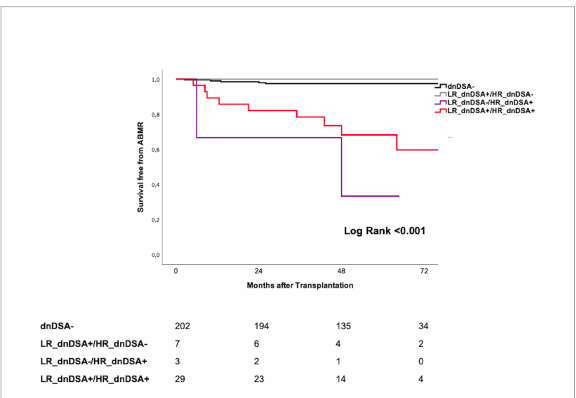
FIGURE 4 Kaplan Meyer Survival curves for ABMR according to different dnDSA identi fi cation. dnDSA, de novo donor -speci fi c antibody; HR, high resolution; LR, low resolution; ABMR, antibody- mediated